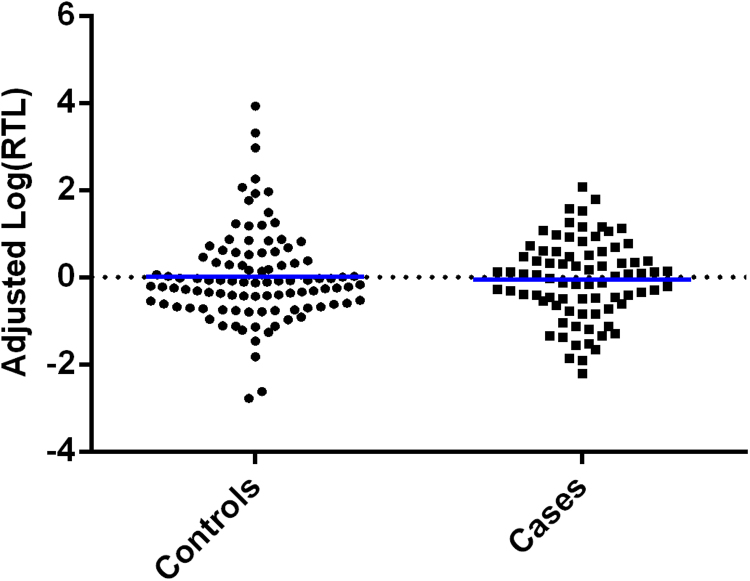
A plot showing log(RTL) adjusted for the effects of age, sex and study (y-axis), in depression cases and controls (x-axis). There were no differences found between cases and controls.